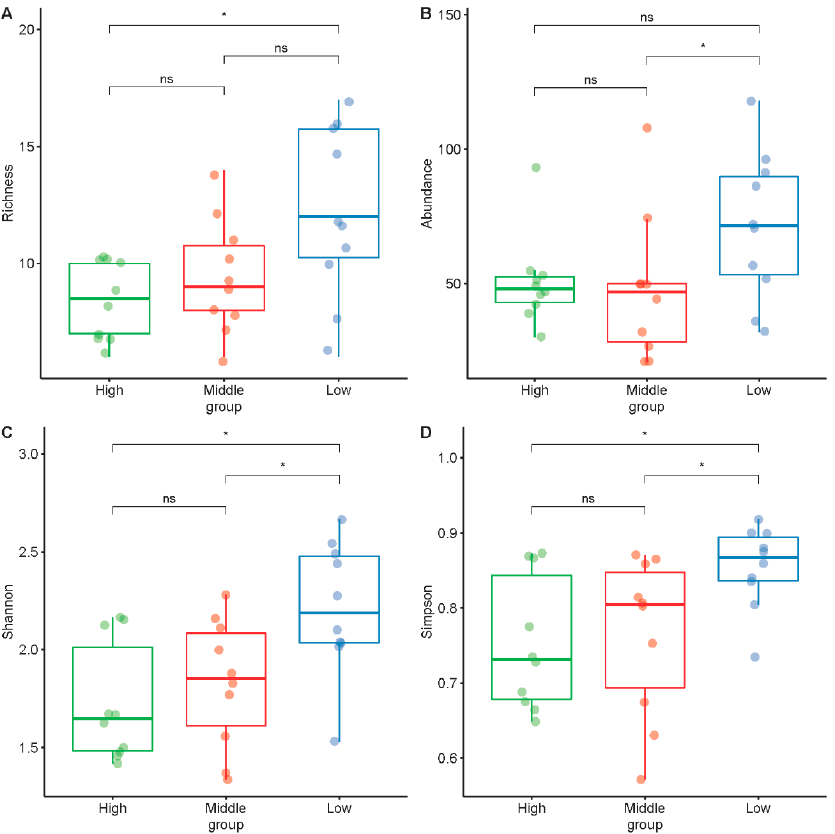
Figure 5. Differences in bird richness ( A ), abundance ( B ), Shannon diversity ( C ) and Simpson diver- sity ( D ) vary along three disturbances of urban mountain parks in Fuzhou, China. Point counts and questionnaires were delivered in three disturbance levels urban mountain parks in Fuzhou, China. Star notation indicates the significance level of analysis with Wilcoxon rank-sum tests (ns = not sig- nificant; * = p < 0.05).